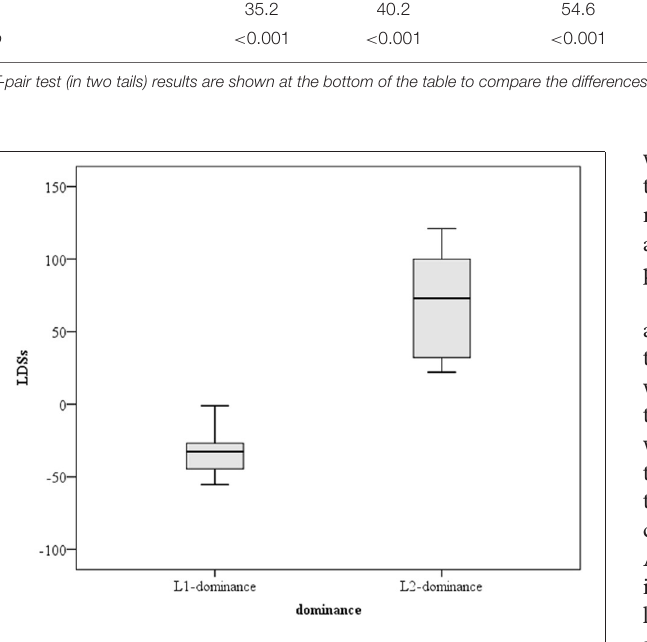
in the pronunciation and the Cantonese scripts of the nonce words. The native speakers were asked to produce the disyllabic pairs with an interval of around one second in a natural speaking speed and the files were sampled at 44,100